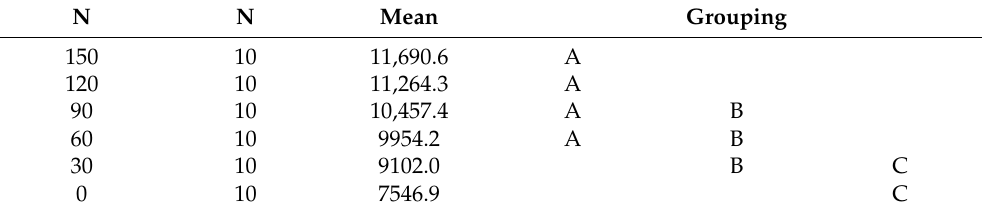
Table 11. Tukey Pairwise Comparisons on N fertilizer.